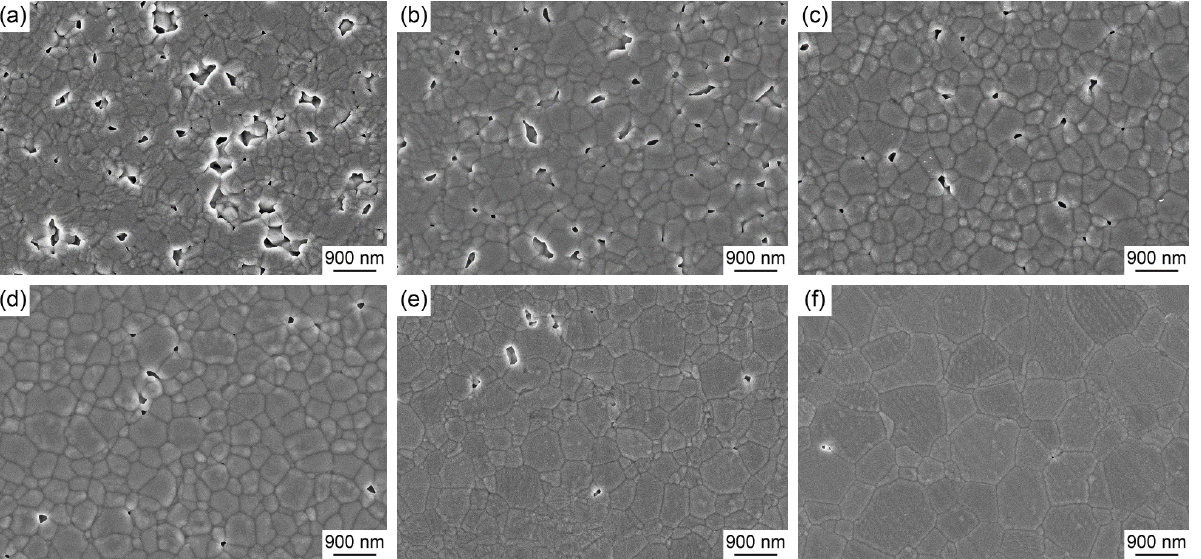
Fig. 2 FESEM micrographs of (a) the granulated 8YSZ powders and (b) the enlarged surface of spherical particles; and (c) the particle size distribution of 8YSZ powders.